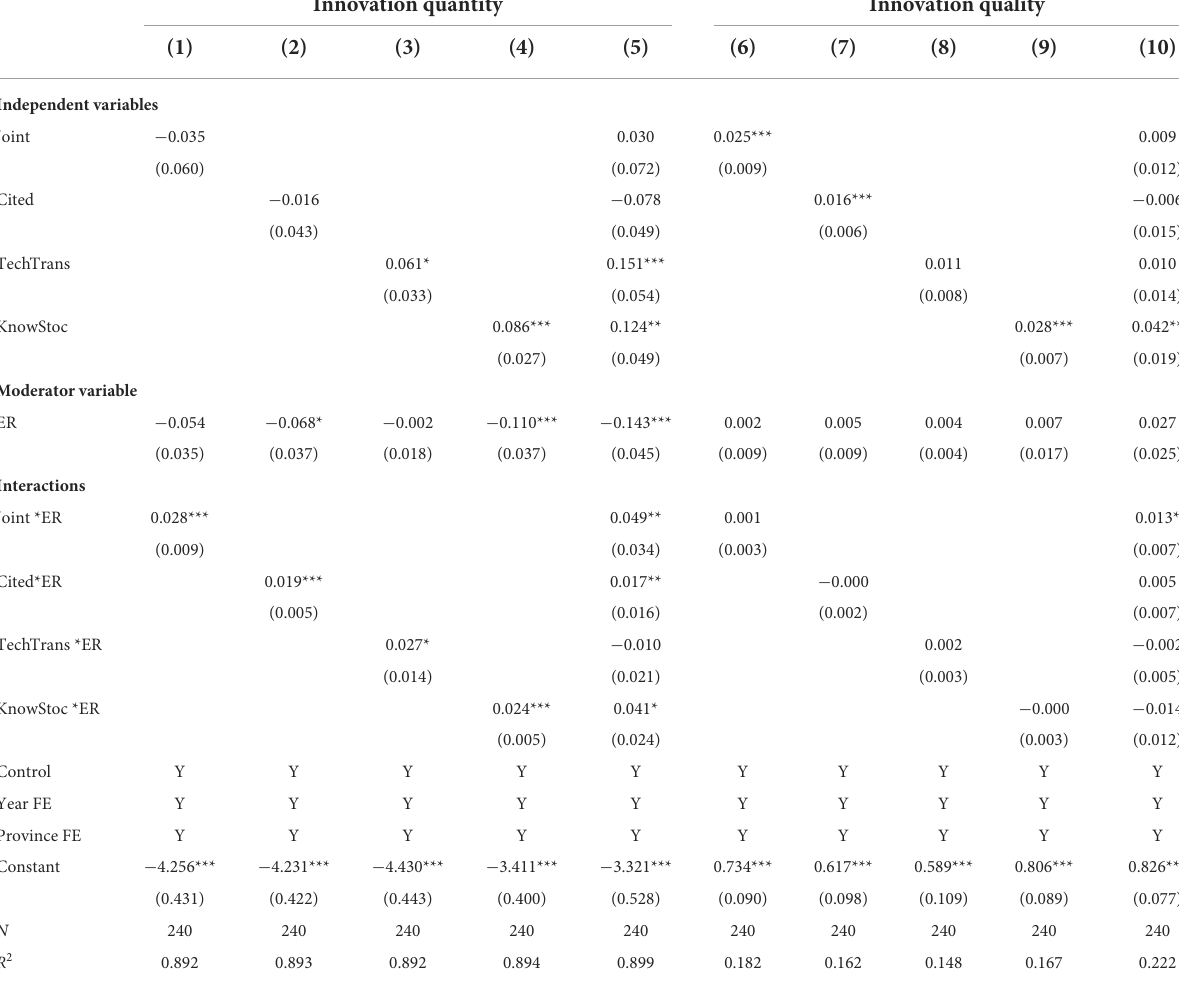
TABLE 5 The moderating effect of environmental regulation level. Innovation quantity Innovation